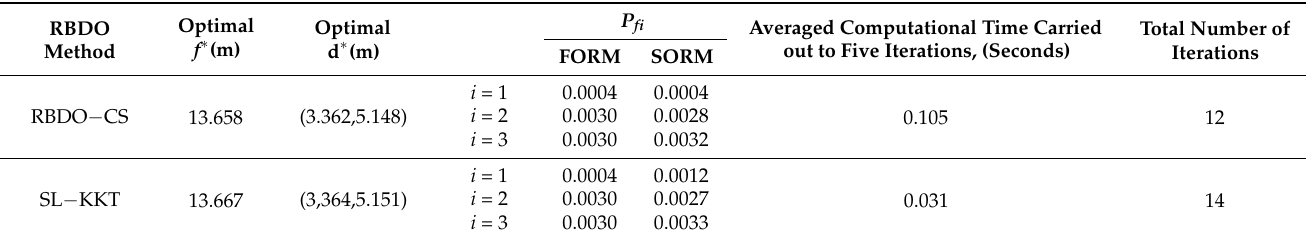
Table 6. Comparison between results from the RBDO − CS and SL − KKT methods for the frame structure problem. RBDO Method